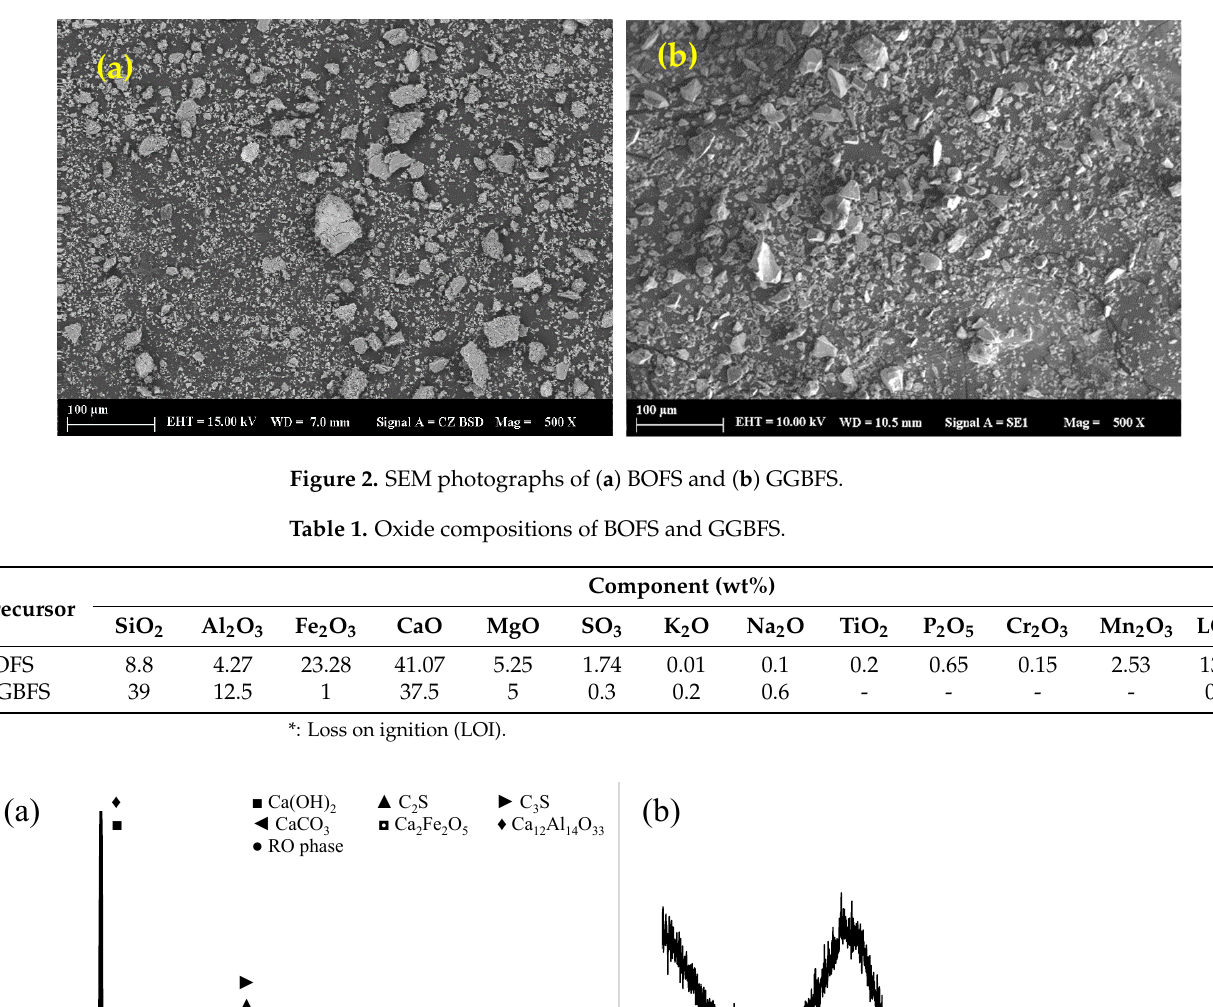
Figure 3. XRD of raw ( a ) BOFS and ( b ) GGBFS.